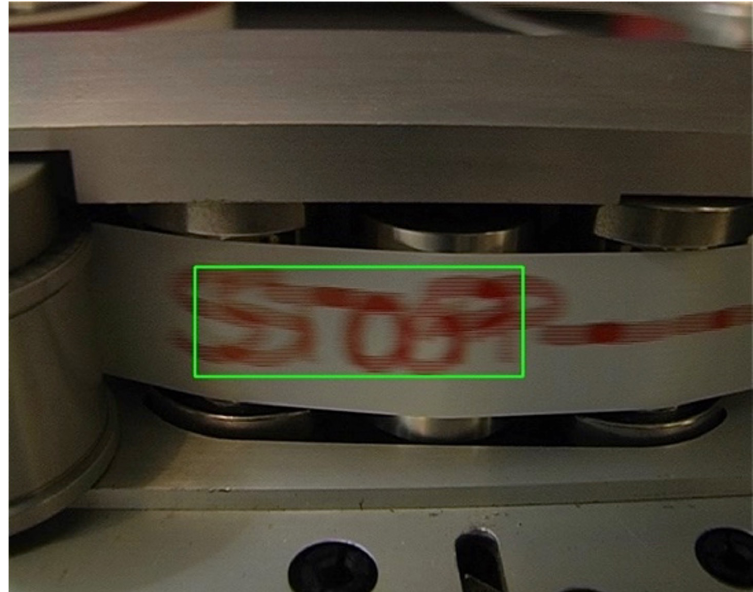
Figure 11. Example of words written on the back of a